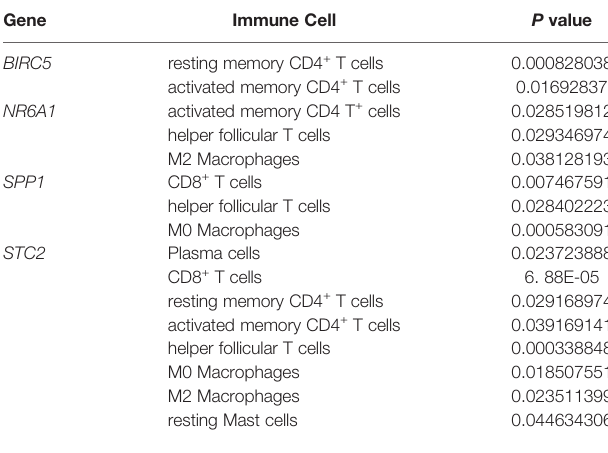
TABLE 2 | Details of immune cells with different contents between the high gene expression group and the low gene expression group. Gene